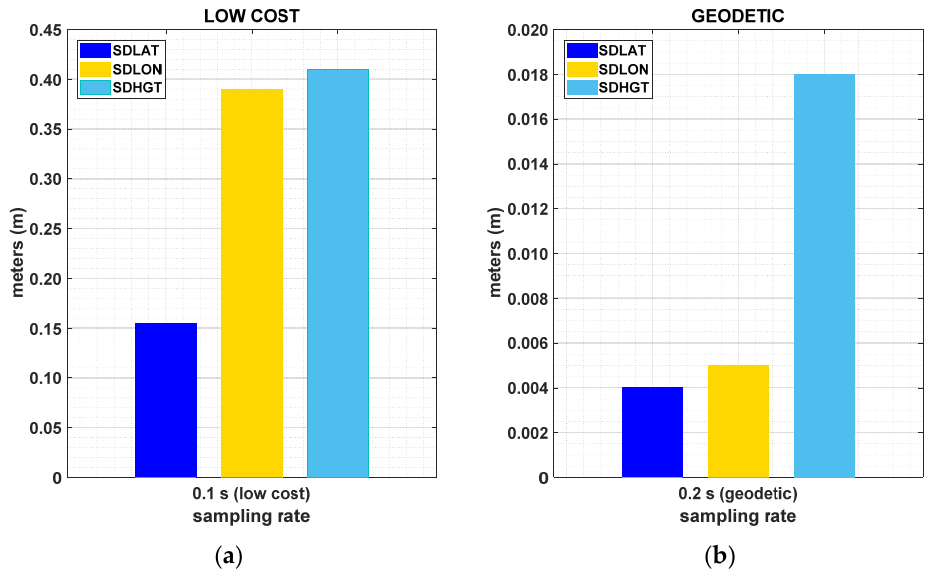
Figure 8. Difference between estimated and precise position of low-cost and geodetic receivers at 0.1 and 0.2 s respectively, by processing with PPP-static mode.